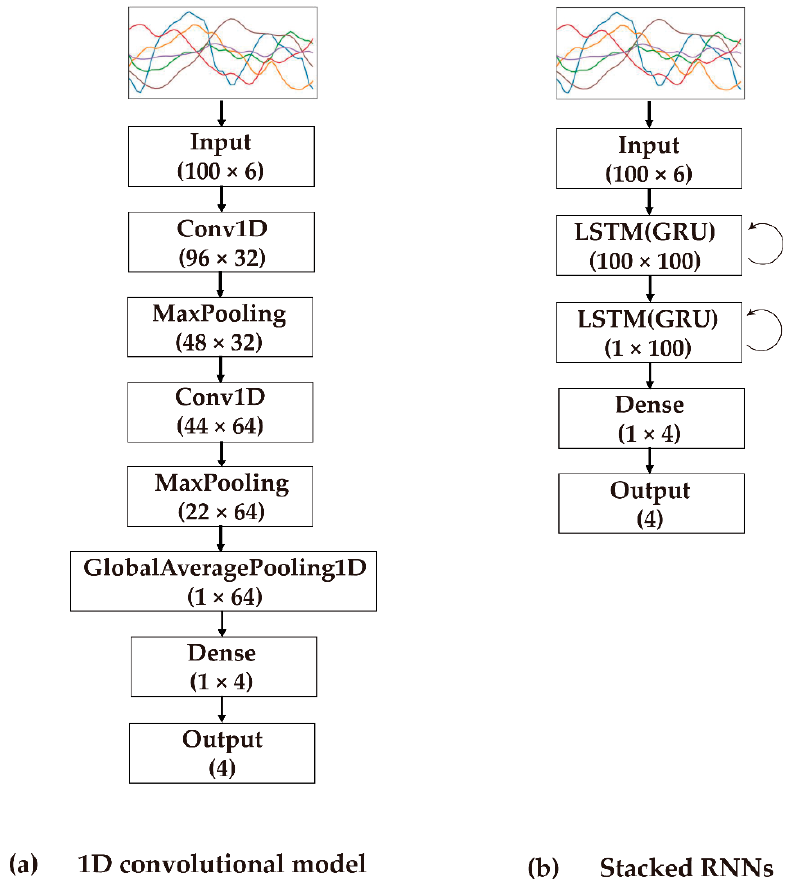
Figure 6. Network architecture used in this study. Here, the diagram above is based on input signal length of L = 100. In case of gated RNNs, LSTM/GRU cells are stacked to learn more complex repre- sentations.